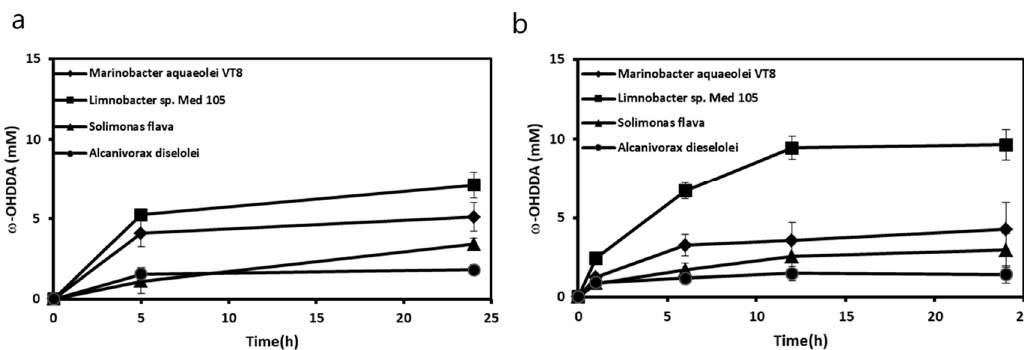
Figure 2. ω -Hydroxylation of 20 mM DDA by CYP153A and Cam AB containing cells,